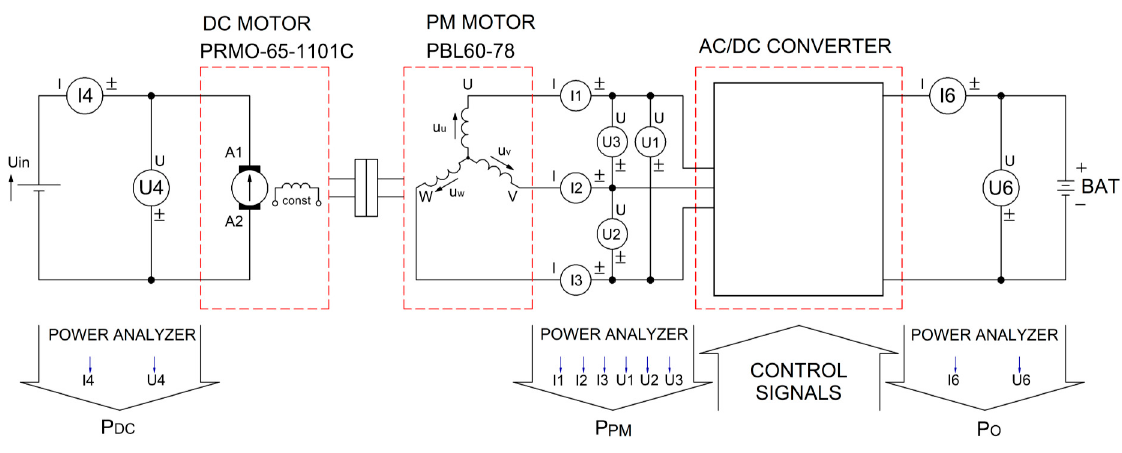
The block diagram of the measurement instrument connections is shown in Figure 11.